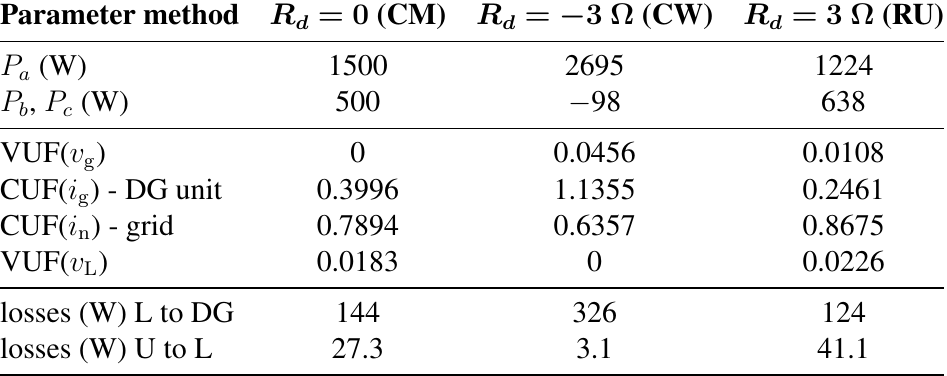
Table 5. Grid-connected microgrid and one DG unit: CM(Conventional Method) versus